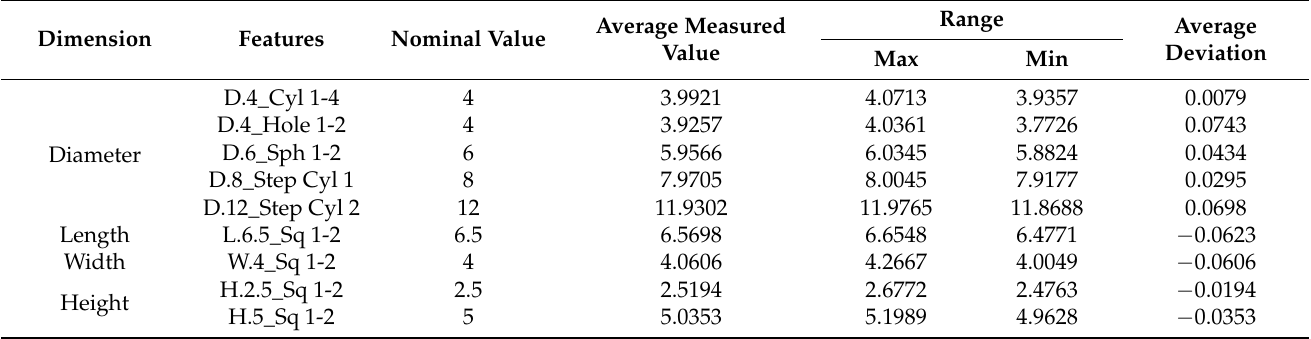
Table 9. Printed patterns measurement results for dimensional accuracy, in mm.